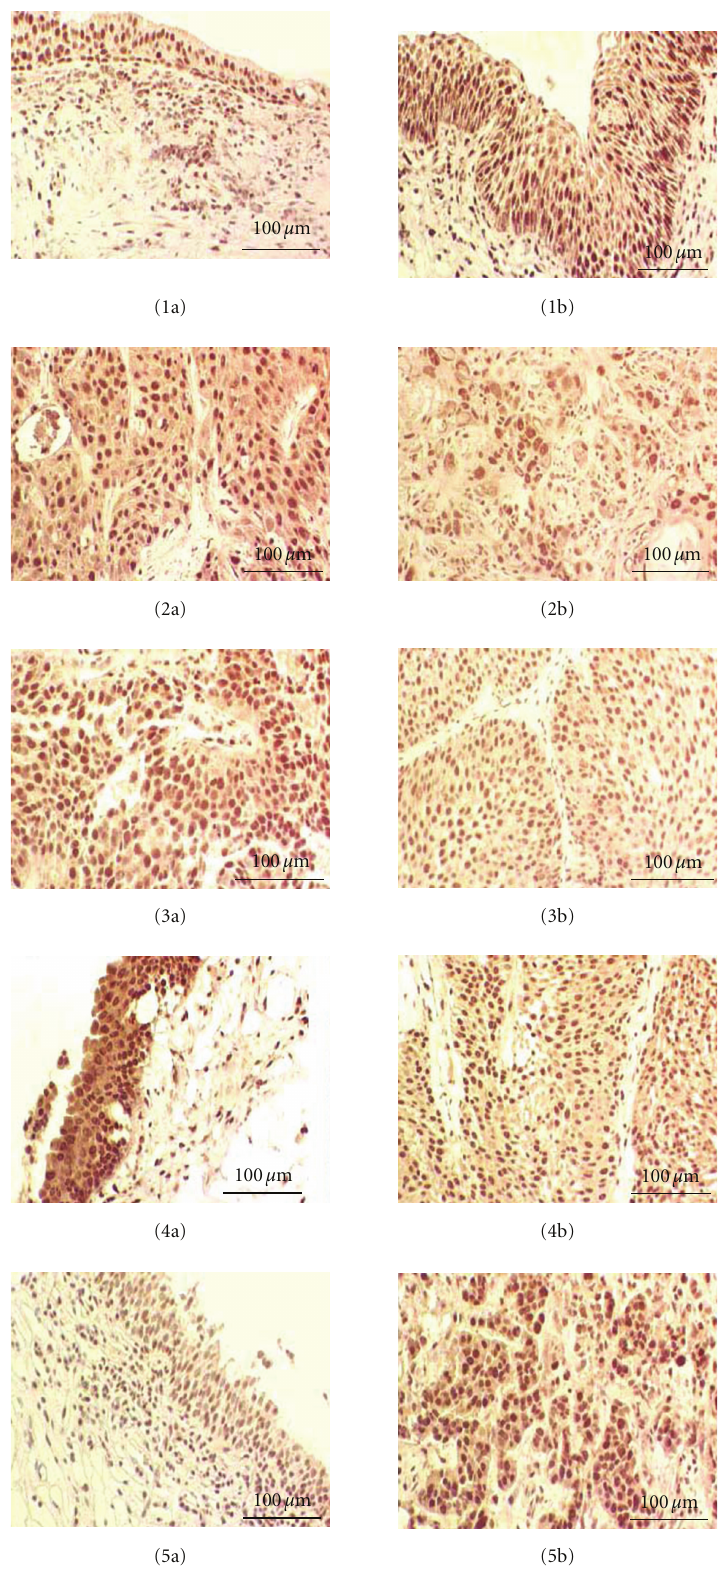
Figure 3: Immunohistochemical detection of MGMT in bladder tissue from patients with bladder cancer: normal urothelium (1a) and squamous metaplastic epithelium 1(b); SCC (2a) and moderately di ff erentiated SCC (2b) sections of bilharzial bladder; invasive TCC (3a) and low grade papillary TCC (3b); non neoplastic urothelium with some dysplastic changes (4a) and grade II papillary TCC (4b); normal urothelium (5a) and invasive TCC (5b). Note that the intensity of staining is highest in the high grade section (5b). Scale bars = 100 µ